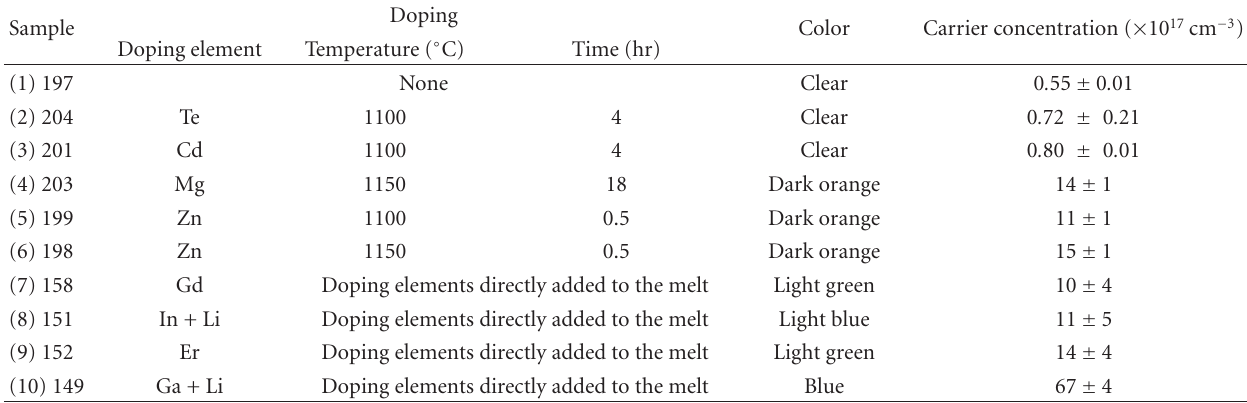
Table 1: ZnO single-crystals